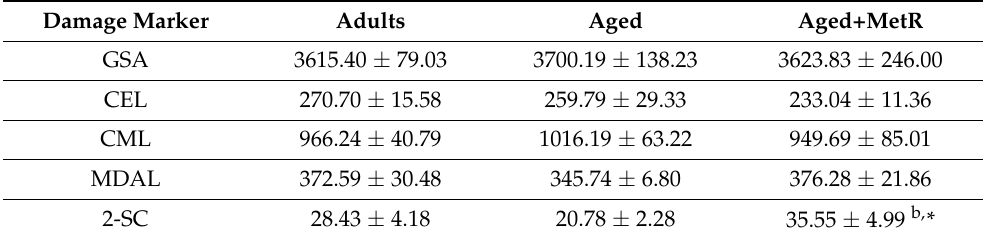
Table 8. Oxidation-derived protein damage markers in the rat frontal